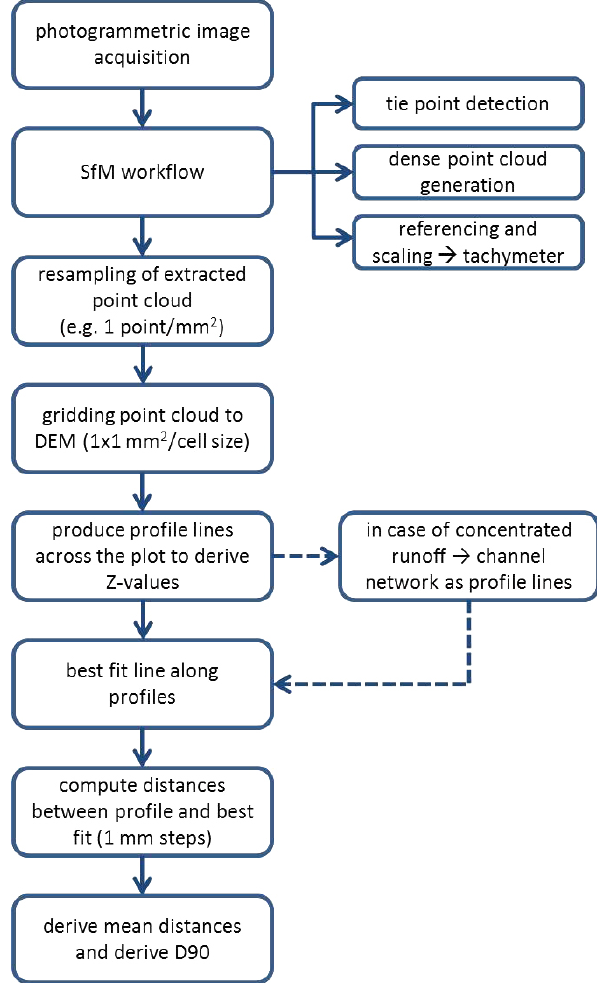
Figure 3. Workflow from image acquisition to roughness values. The dotted branch shows the possibility to implement depression lines derived from the channel network in SAGA GIS in case of concentrated rill